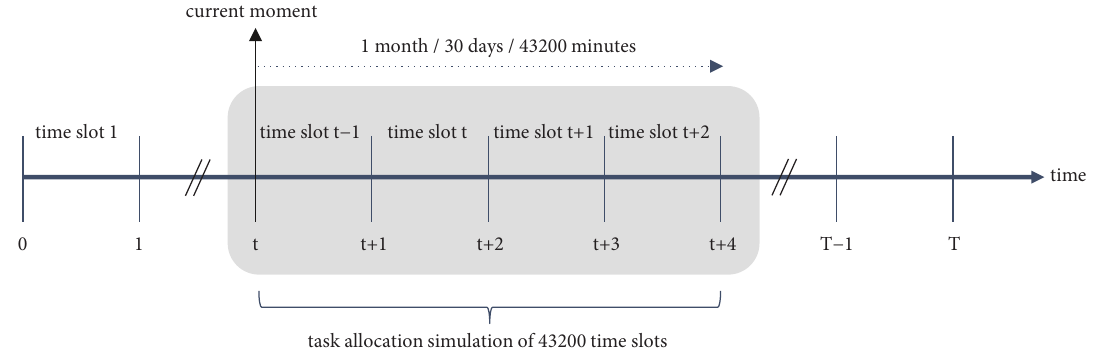
Figure 5: Dispatching simulation process of 1 month.